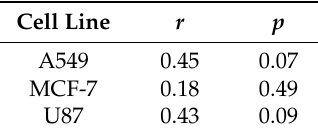
Table 2. The correlation between trihydroxyflavone anti-proliferative and antioxidant activity Cell